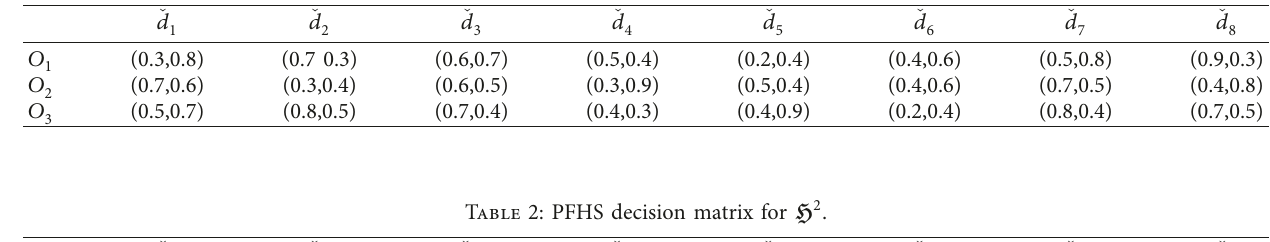
Table 1: PFHS decision matrix for H 1 .